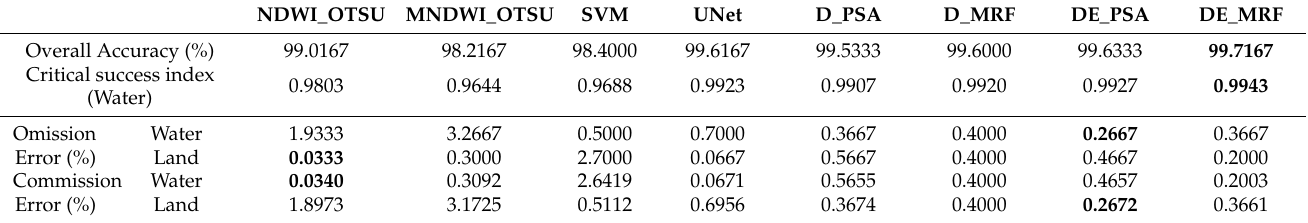
Table 2. Quantitative assessment results of different methods using the 6000 sample points that are randomly selected in the image as highlighted with yellow points in Figure 5. The highest overall accuracy, highest critical success index, lowest omission, and lowest commission errors are in bold.